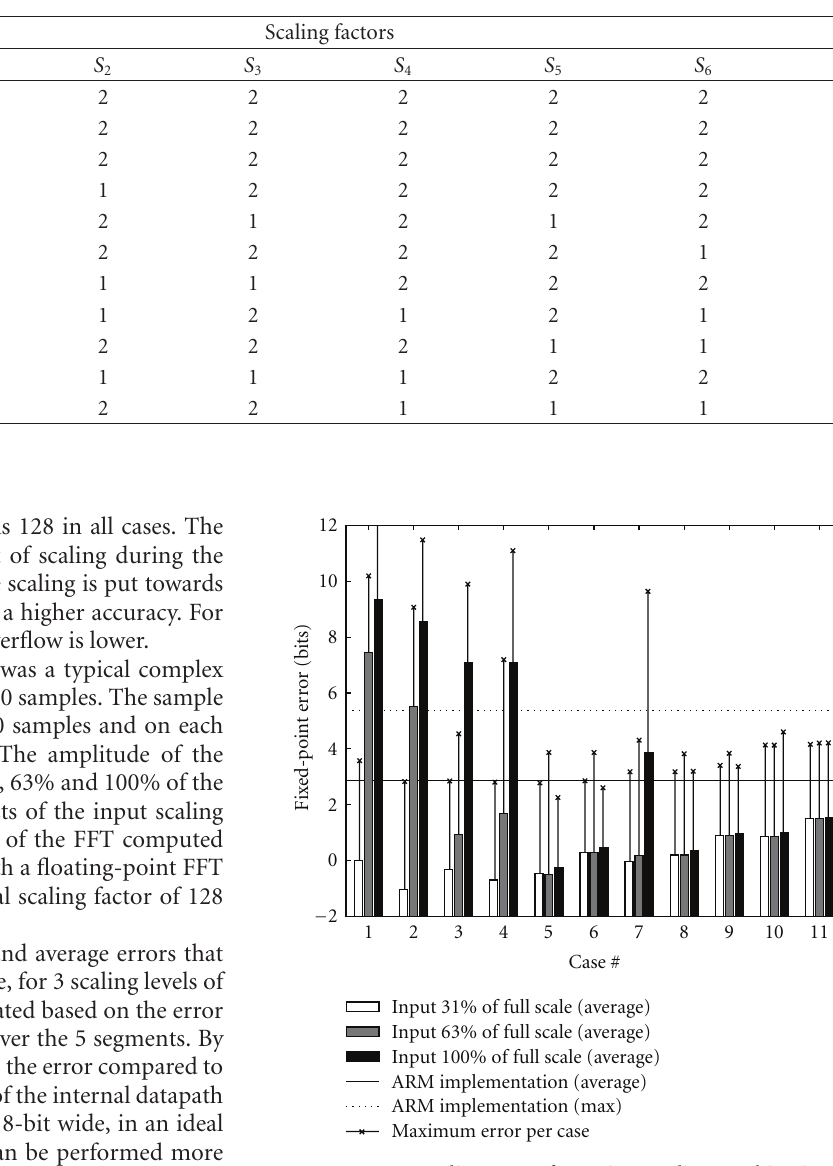
Figure 10: Rounding errors for various scaling